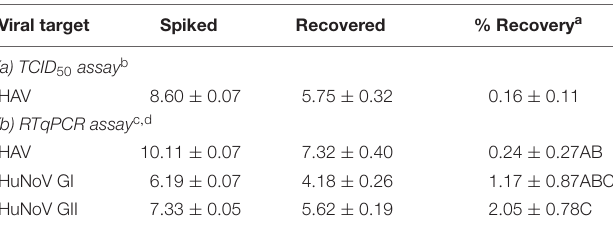
TABLE 1 | Recovery efficiencies of spiked viruses (average ± standard